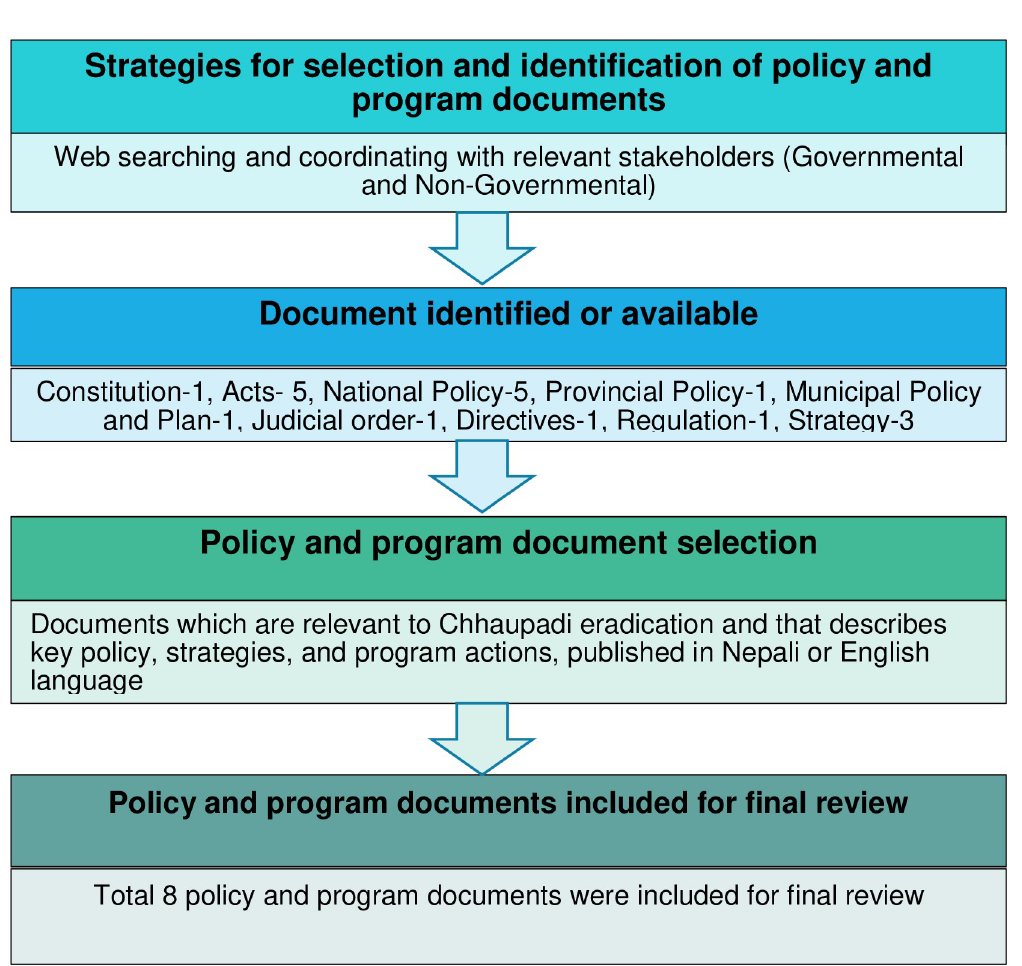
Fig 2. Flowchart of selection of policy and program documents on Chhaupadi eradication in